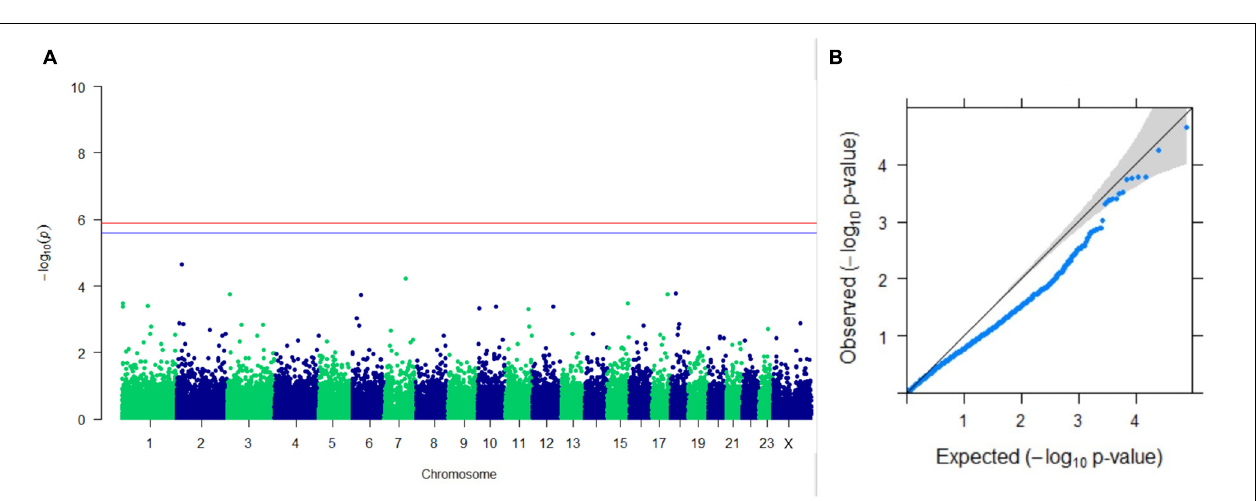
FIGURE 12 | Results of GWAS for age at sexual maturity. (A) Manhattan plot of genome-wide SNPs. The red line indicates the p- value threshold (expressed as –log 10 P ) corresponding to FDR-corrected p- values or q = 0.05, above which the SNPs are considered to be significantly associated with the trait, while the blue line indicates the genome-wide suggestive threshold at q = 0.1. The SNPs identified on chromosome no. 24 were screened out from analysis because of stringent quality control; hence, it is not represented in the Manhattan plot. (B) Q-Q plot of the p-